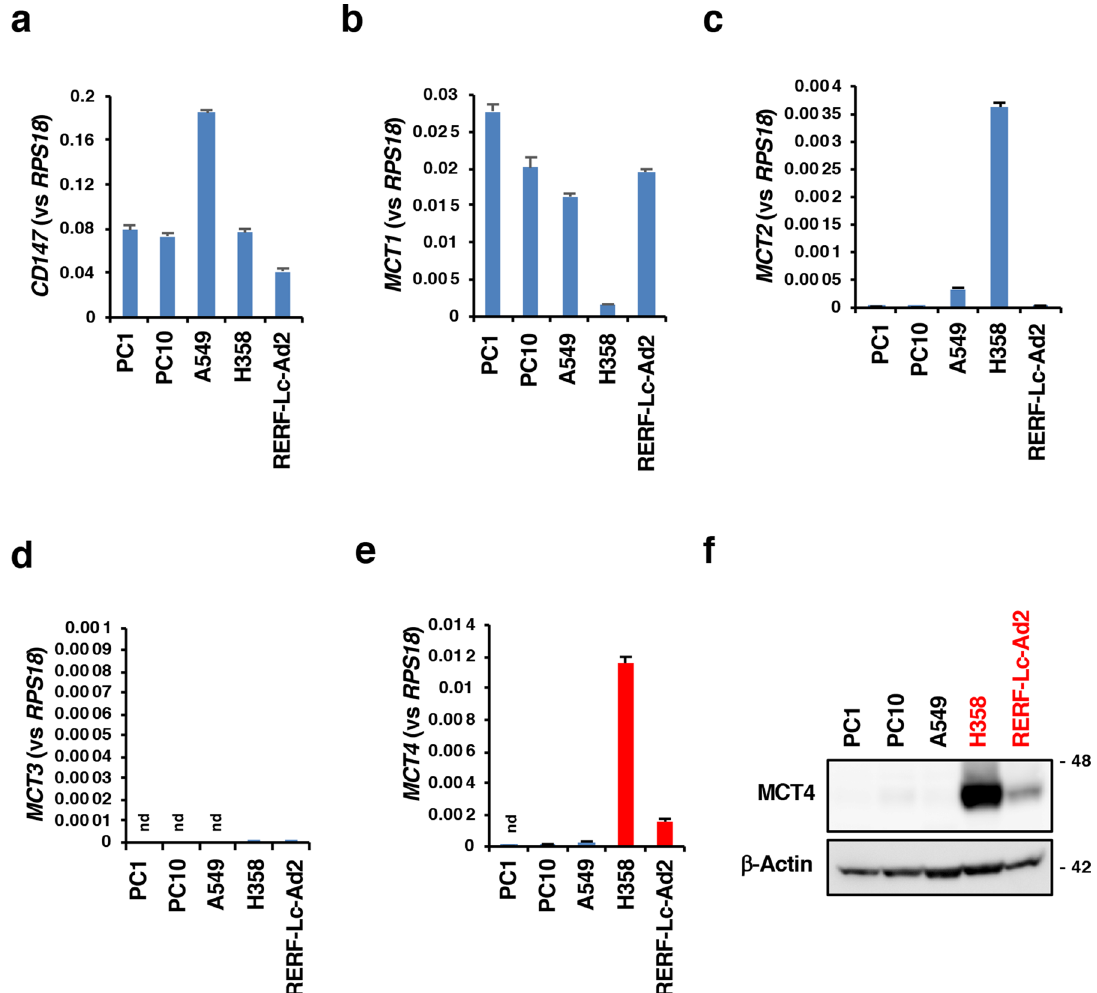
Figure 4. MCT expression in NSCLC cell lines. ( a – e ) RT-qPCR analysis of the expression of CD147 and MCT1-4. nd: not detected. ( f ) Western blot analysis of MCT4 expression. β-Actin was used as a loading control. Uncropped Western blot images are shown in Supplementary Fig.